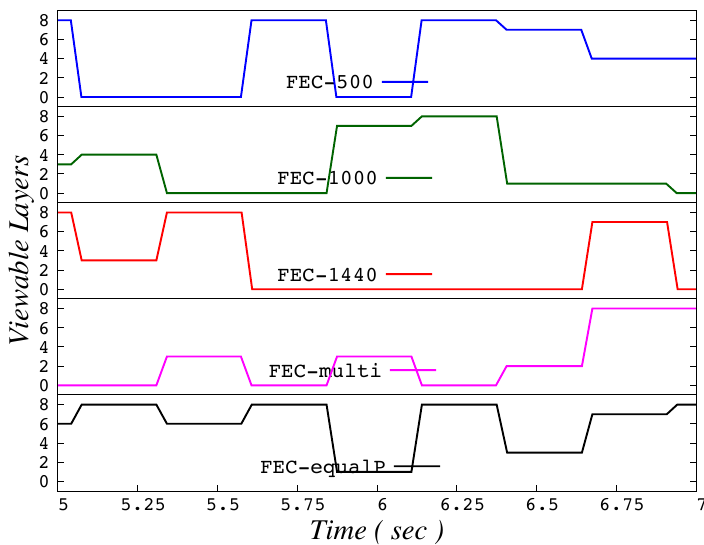
Figure A11. A two-second example of variation in viewable quality for all FEC schemes, at a packet loss rate of 10% and a GOP of 8.